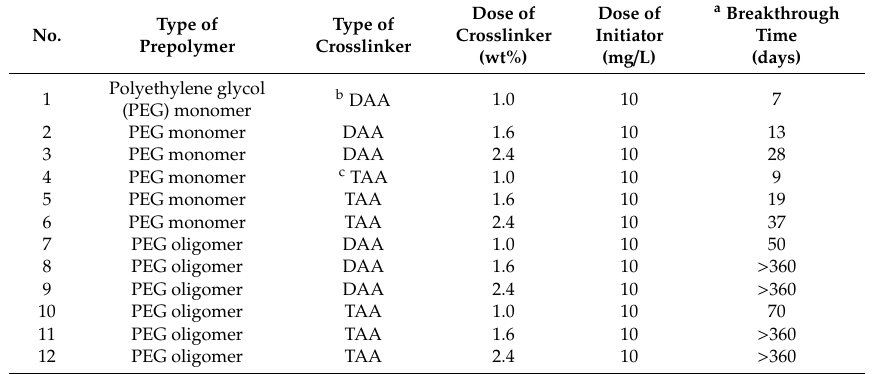
Table 1. Partial list of total organic carbon (TOC) leak test results in di ff erent preparation conditions. No.